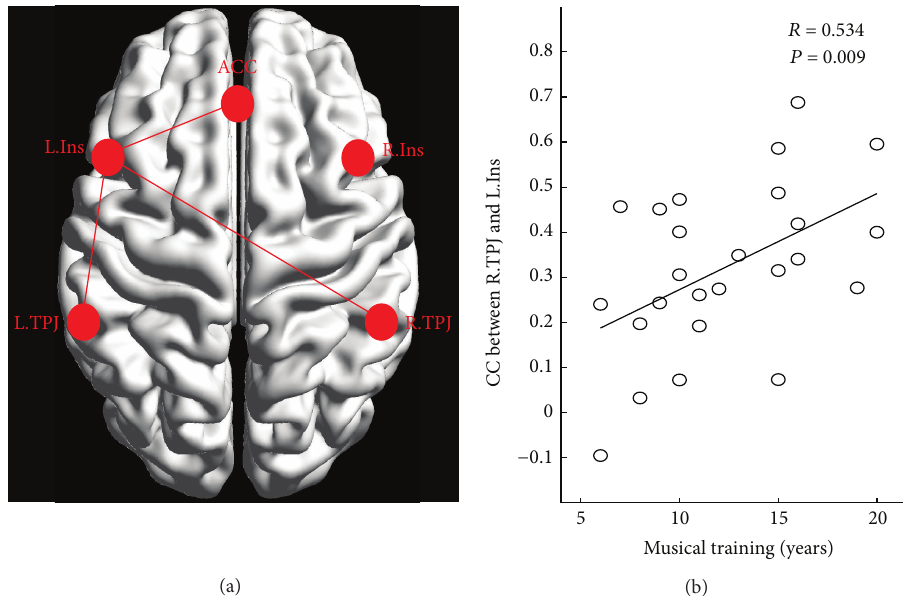
Figure 4: Significantly increased functional connectivity between ROIs in musicians compared with nonmusicians (a) and the relationship between the functional connectivity and musical training duration (b). ROIs’ abbreviations are consistent with those shown in Table 1, and the abbreviation “CC” meant correlation coefficient. Table 2: The 𝑒𝑡𝑎 2 coefficient between functional connectivity maps seeded at 10 ROIs in musicians and nonmusicians.